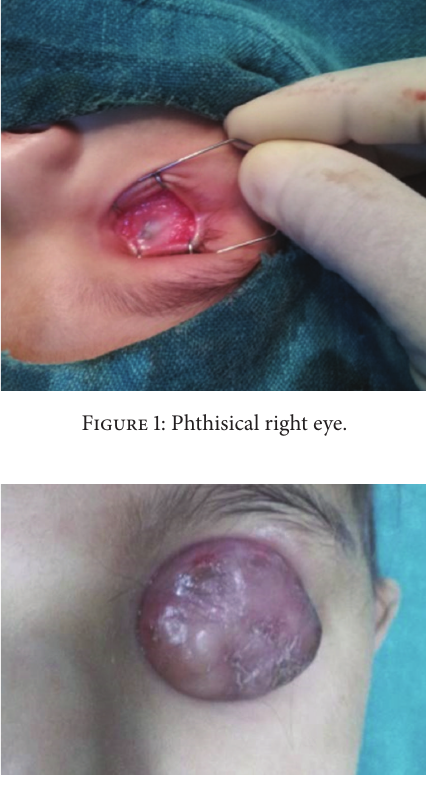
Figure 2: Cauliflower like mass in the left eye. bal area, cornea, and anterior segment (Figure 5). The optic nerve stump appeared to be normal (Figure 6).